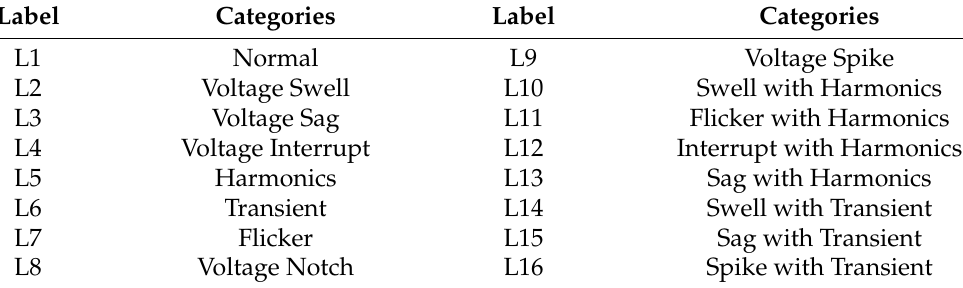
Table 1. The sixteen types of